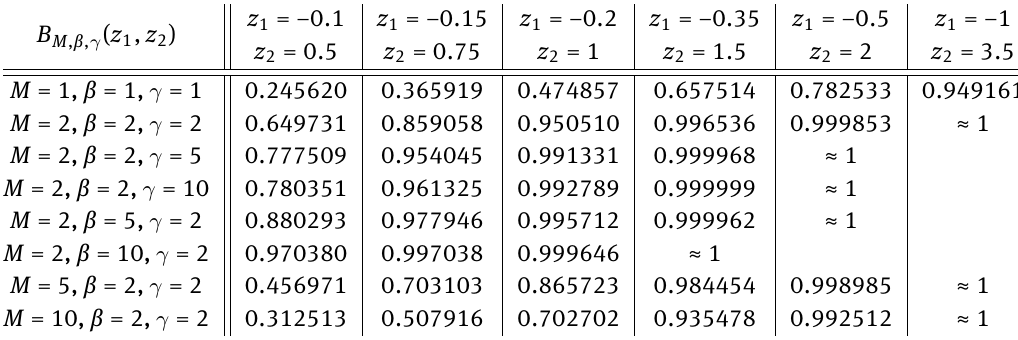
Table 3: Heaviness of the tails of maximum distribution in jointly l 3, p -symmetrically Kotz type distributed populations for p = 1 and the choices of parameters M > 1 − 3 , β > 0 and γ > 0 from Figure p